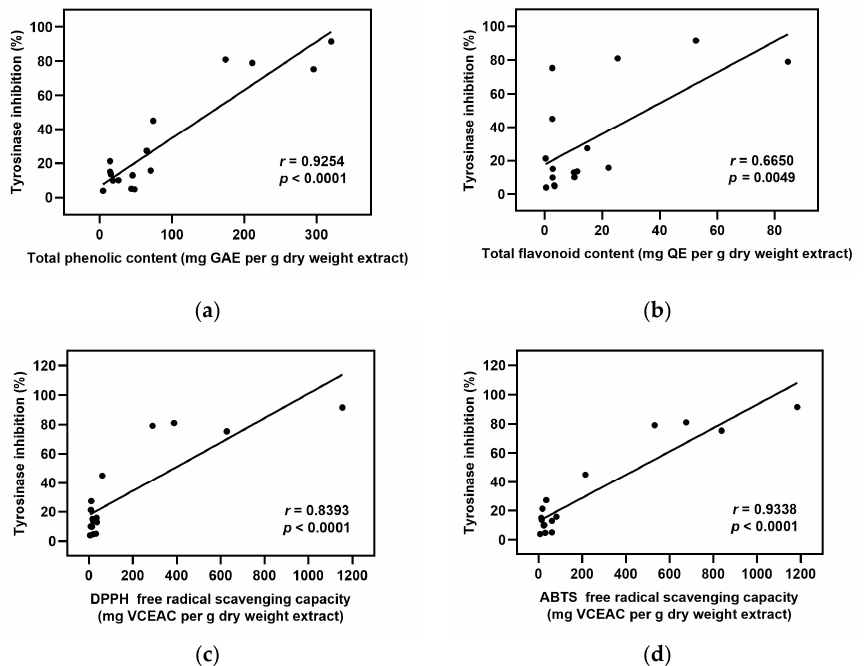
Figure 2. Correlation analysis between tyrosinase inhibition and values in Tables 1 through 4 were expressed as Pearson’s correlation coefficients ( r ): ( a ) tyrosinase inhibition versus total phenolic content; ( b ) tyrosinase inhibition versus total flavonoid content; ( c ) tyrosinase inhibition versus DPPH free radical scavenging activity; ( d ) tyrosinase inhibition versus ABTS free radical scavenging activity.